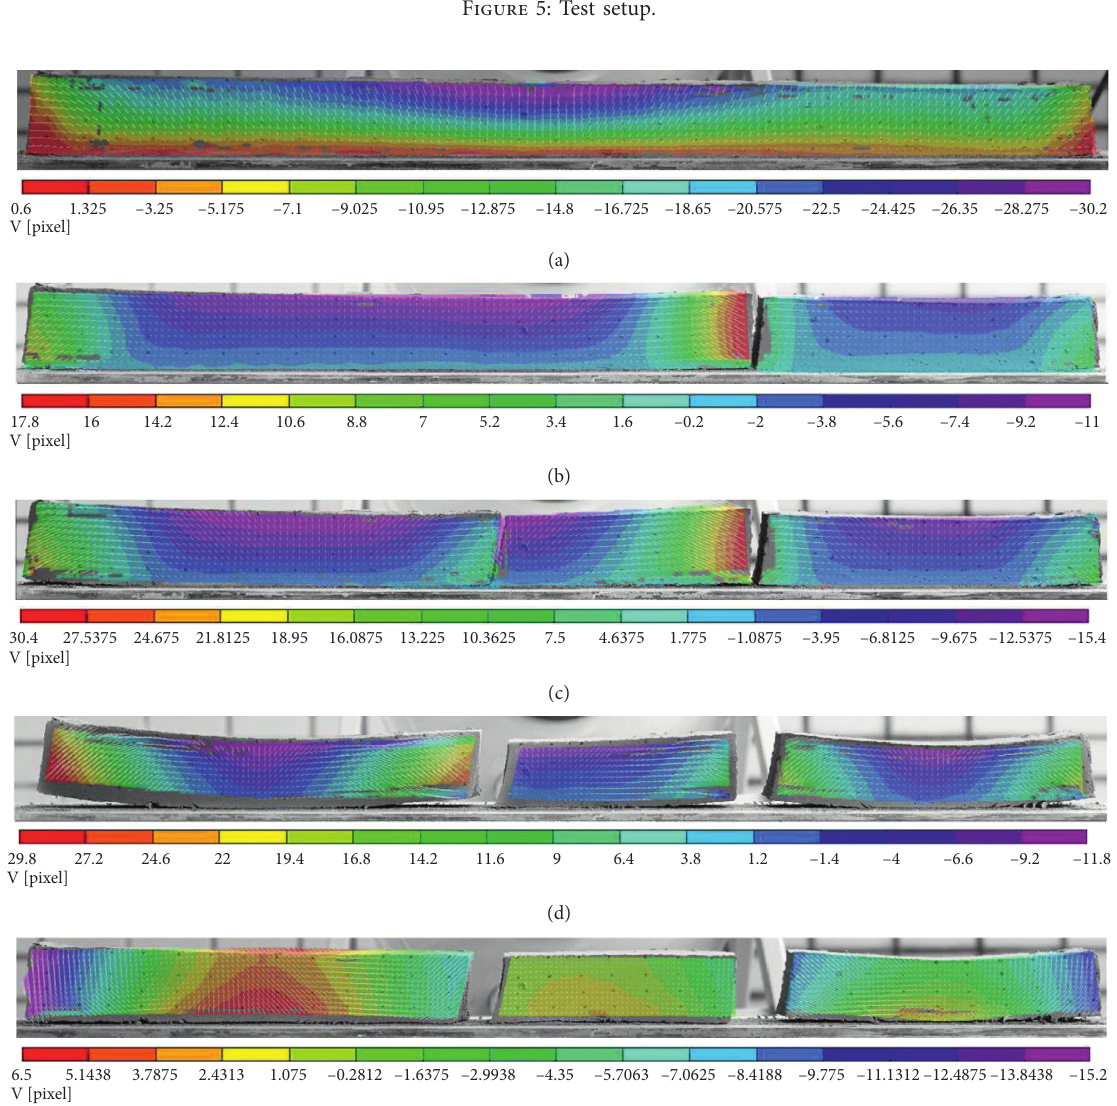
Figure 6: The vertical displacement fields over a drying period of (a) 850min; (b) 1050min; (c) 1200min; (d) 2000min; (e) 2500min.